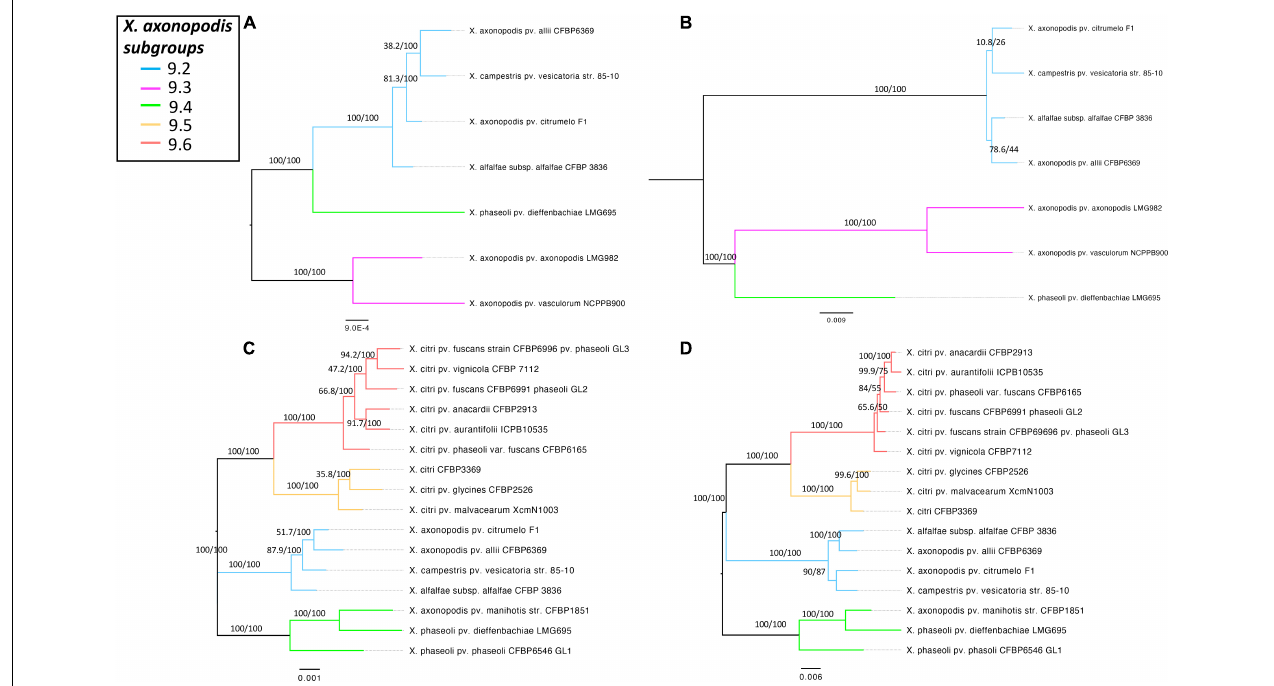
FIGURE 4 | Comparison of the core genome phylogeny of X. axonopodis subspecies with T6 i3 ∗∗∗ /i3 ∗ core genome phylogeny to T6 i3 ∗ /i3 ∗∗∗ core gene phylogeny. (A) Core genome phylogeny for the strains with i3 ∗∗∗ . (B) T6SS i3 ∗∗∗ phylogeny. (C) Core genome phylogeny for the strains with i3 ∗ . (D) T6SS i3* phylogeny. Core genome phylogenies were developed based on the core alignment of nucleotide sequences using the Roary pipeline (Page et al., 2015), whereas T6 phylogenies were generated using the automated multilocus sequence analysis pipeline (automlsa2). Midpoint rooted phylogenetic tree in maximum likelihood (ML) criterion was developed using the IQ-TREE, and branch support was determined using 1,000 bootstraps and 1,000 SH-aLRT bootstrap